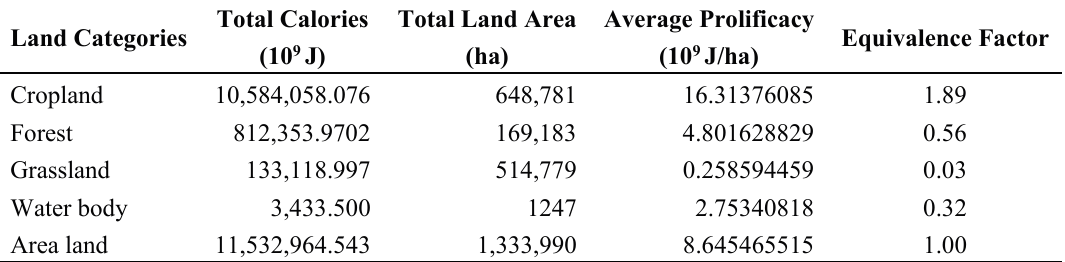
Table A4. Productivity and equivalence factors of land in Guyuan in